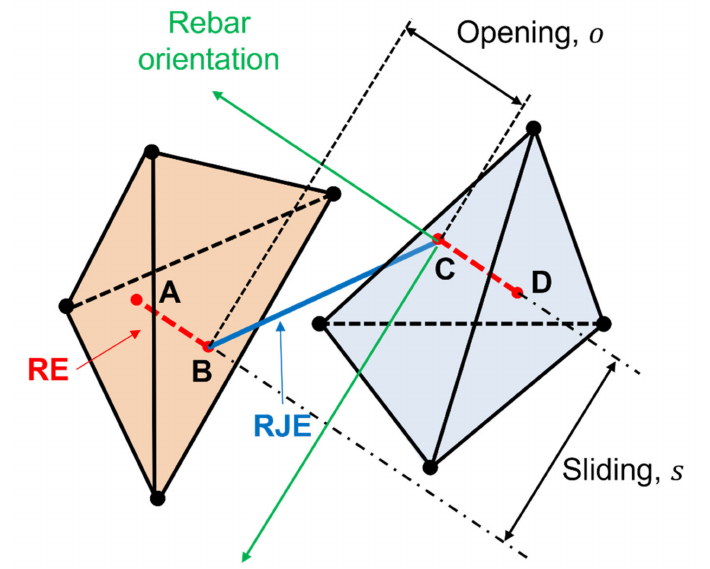
Figure 4. The opening and sliding definitions for the RJE (point B-C in the